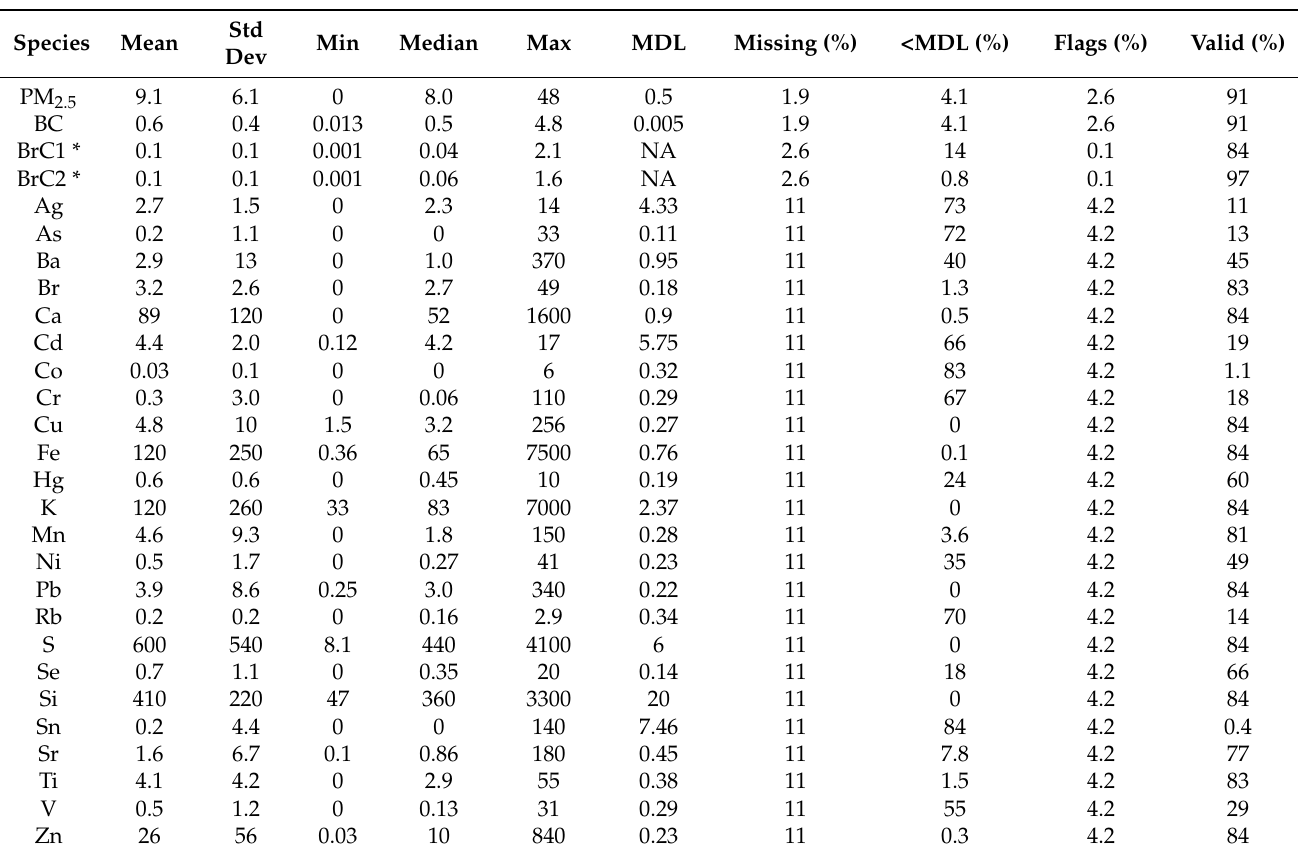
Table 1. Statistics of hourly concentrations for PM 2.5 , BC and BrCs ( µ g/m 3 ), and PM 2.5 -bound elements (ng/m 3 ) between April and October 2021 (N =